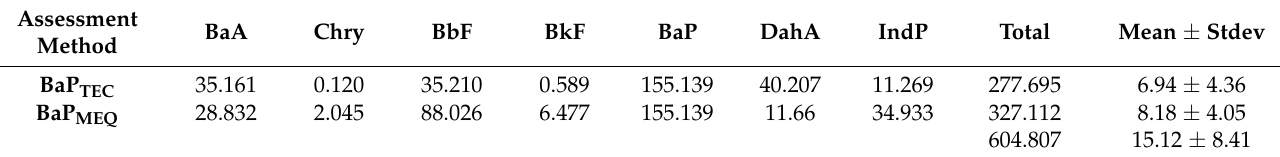
Table 6. Benzo(a)pyrene toxic equivalency quantities (BaP TEQ ) and mutagenic equivalency quantities (BaP MEQ ) levels. Assessment